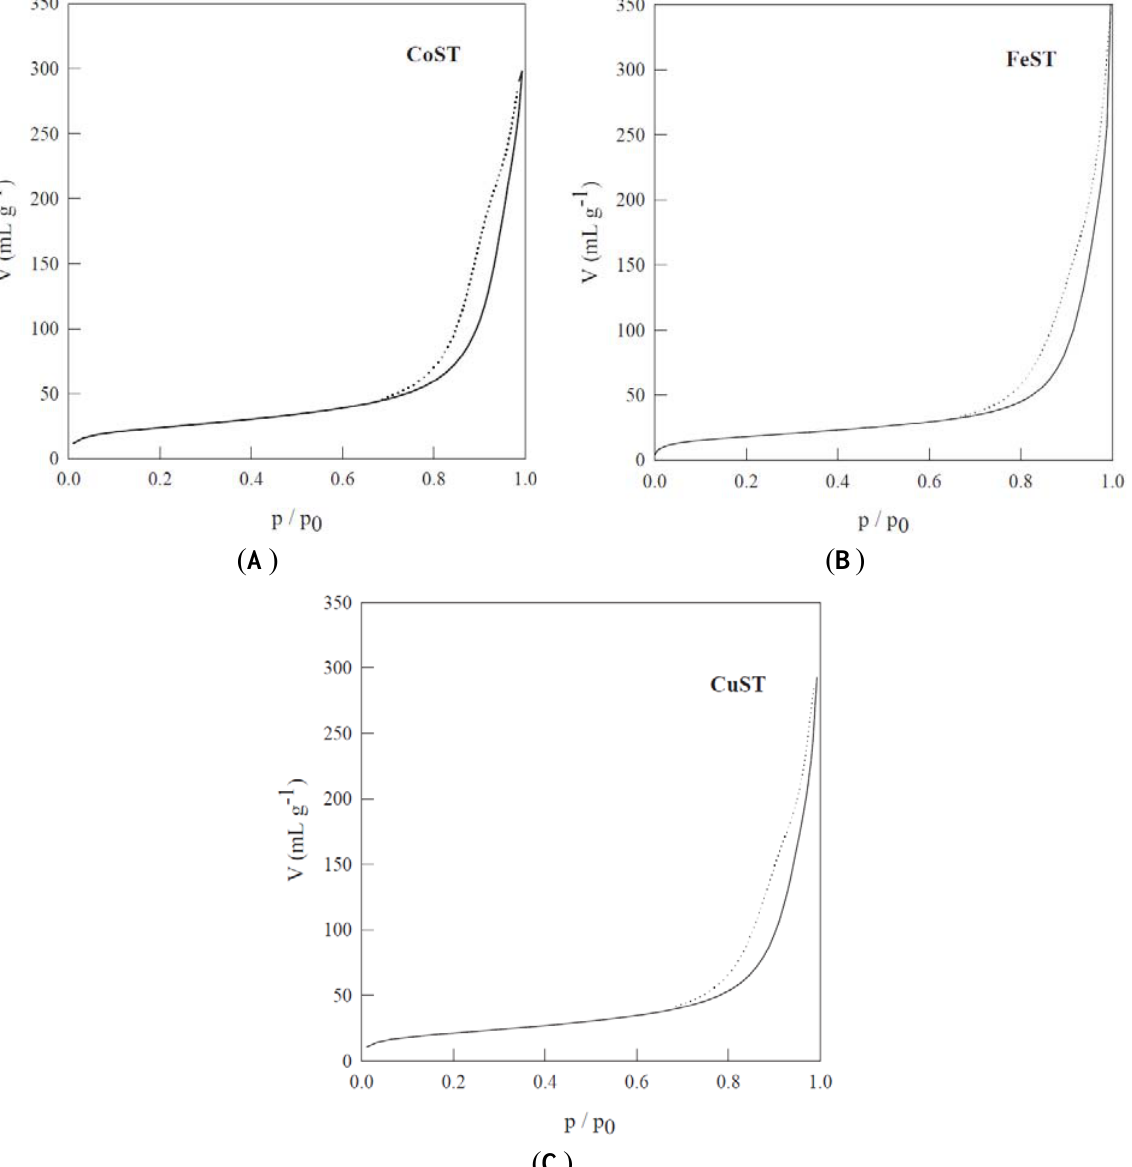
Figure 4. N physisorption experiments corresponding to materials: ( A ) CoST; ( B ) FeST 2 and ( C )